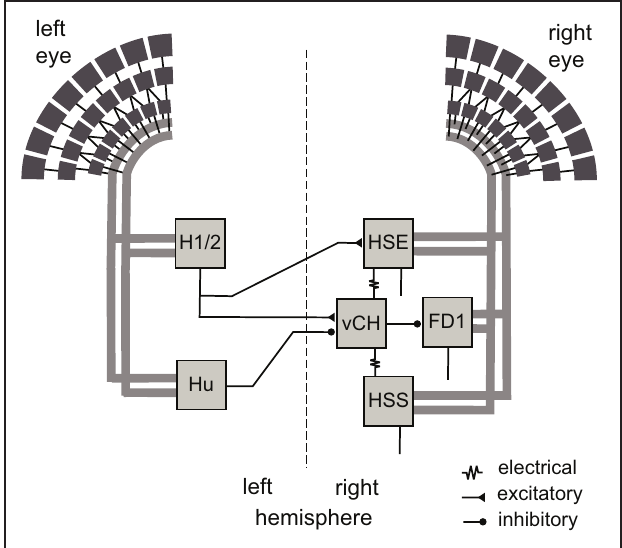
FIGURE 1 | Wiring sketch of the FD1 cell input circuit. Motion-sensitive elements of the right FD1 circuit that have a horizontally preferred direction. The FD1 cell and most of its presynaptic elements presumably receive retinotopic motion input (thick gray lines) from large parts of one eye. The right vCH cell inhibits the FD1 cell and receives itself excitatory and inhibitory input from motion sensitive LPTCs of both brain hemispheres. The left H1 and left H2 excite the right vCH cell, whereas the left Hu cell inhibits it. The right HSE cell and the right HSS cell are electrically coupled to the right vCH cell. FD1, HSE, and HSS are output neurons of the optic lobe, whereas H1, H2, Hu, and vCH connect exclusively to other